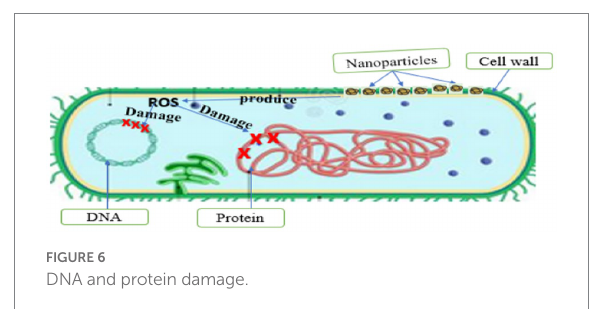
FIGURE 6 DNA and protein